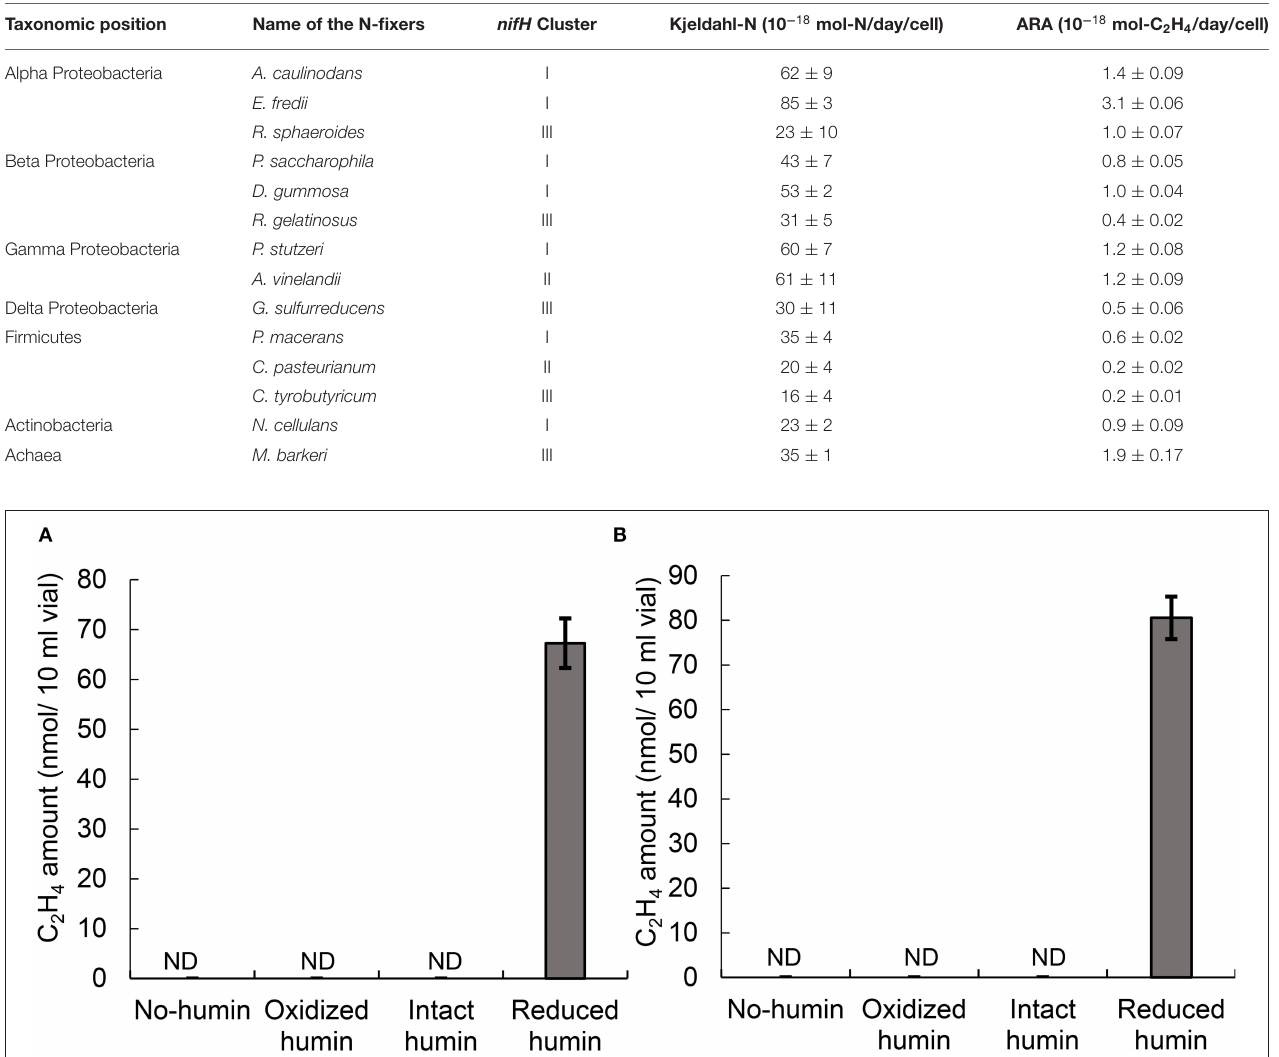
TABLE 2 | Effect of reduced humin on the N-fixation activity of various heterotrophic diazotrophs, as increased Kjeldahl nitrogen (Kjeldahl N) and acetylene reducing activity (ARA) under organic carbon source-free conditions. Taxonomic position